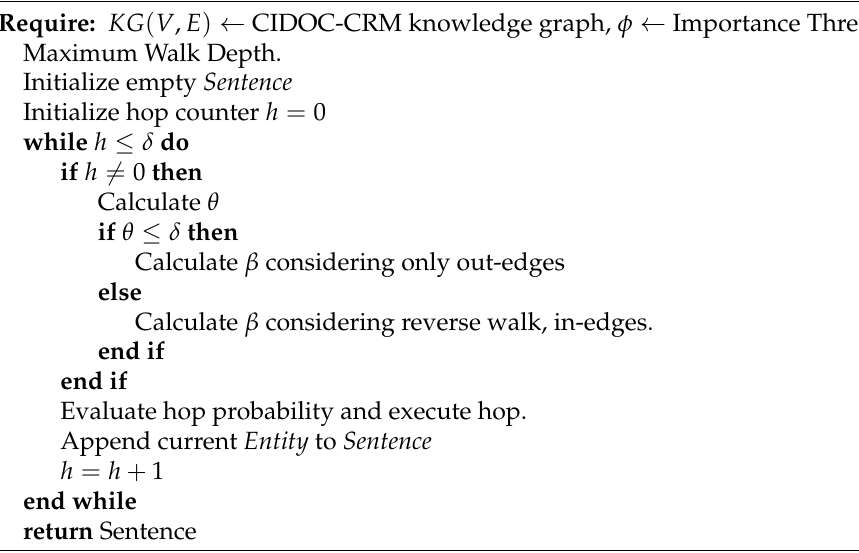
Figure 5. doc2vec algorithm, modified after [36]. Algorithm 2 Relative Sentence Walk,